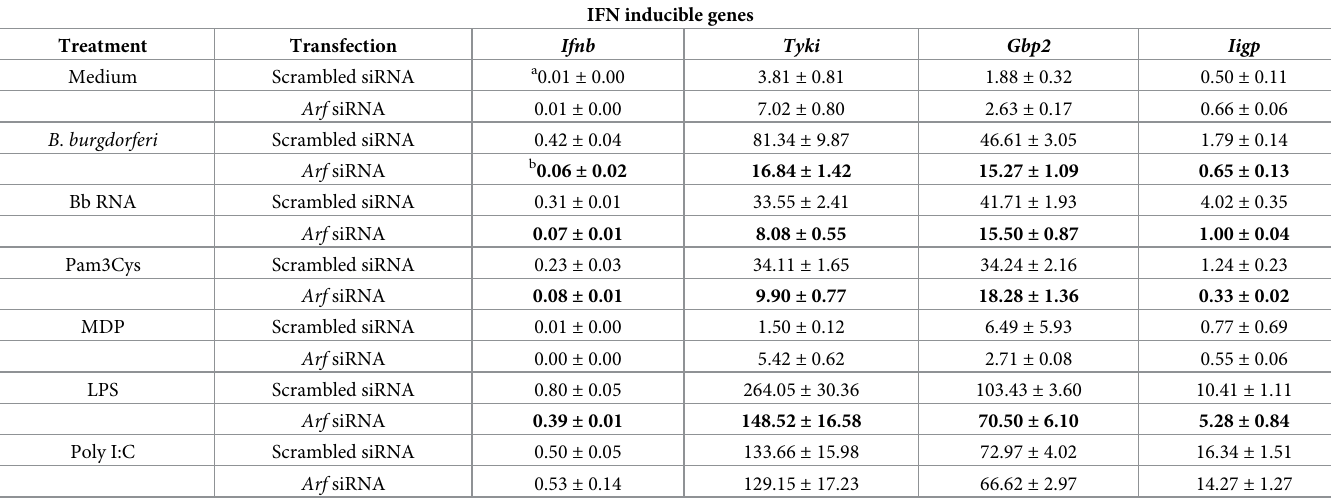
B6.C3- Bbaa1 BMDMs were transfected with Arf or scrambled siRNAs using the Neon electroporation system. After 48 h of recovery, the transfected macrophages were treated with 5 μ g/ml sonicated B . burgdorferi , 2 μ g/ml B . burgdorferi RNA, 200 ng/ml lipopeptide Pam3Cys, 10 μ g/ml MDP, 100 ng/ml LPS, or poly I:C (10 ng/ml or 20 μ g/ml) for 6 h prior to sample collection. Transcripts were assessed by qPCR. a Values represent mean ± SEM. b Numbers in bold indicate a significant decrease in induction of the indicated transcript following Arf silencing compared with cells receiving scrambled